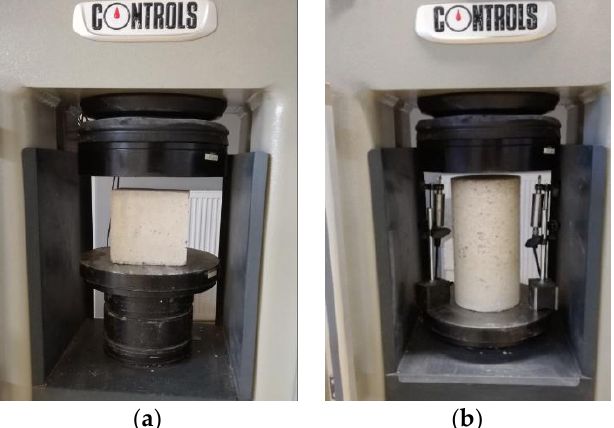
Figure 5. ( a ) Compressive strength testing arrangement; ( b ) stress-strain behavior testing